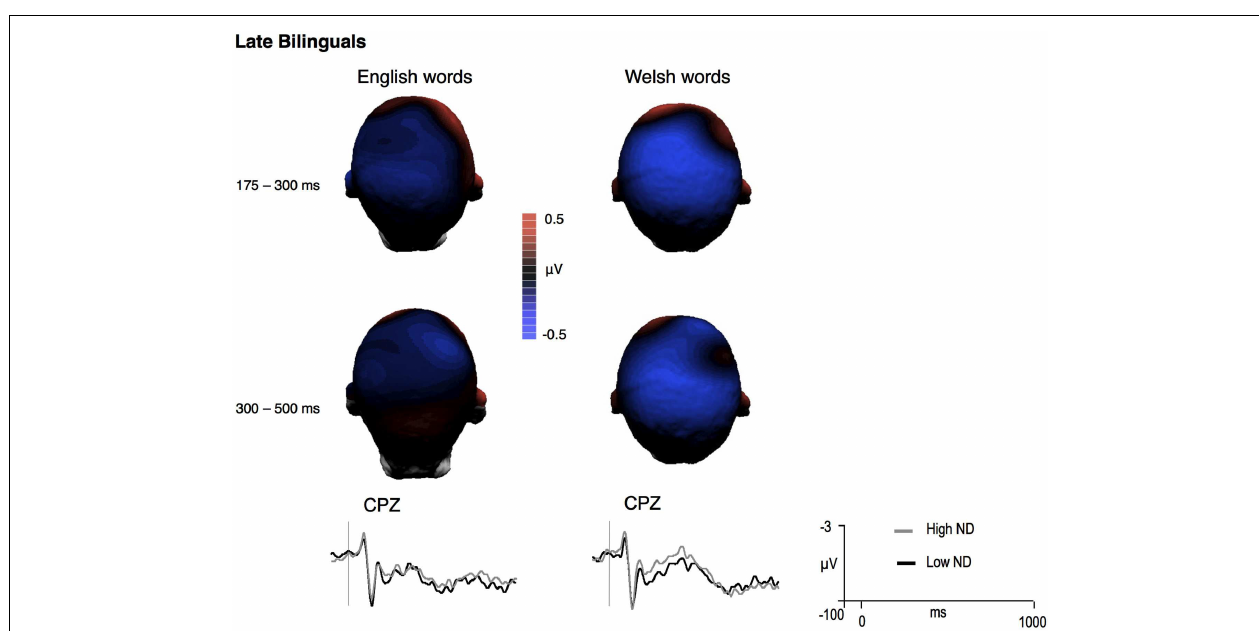
FIGURE 3 | Difference voltage maps representing the cross-language ND effect (high ND – low ND) in late bilinguals and mean grand-averages ERPs at the site where the effect was largest (negative is plotted up).